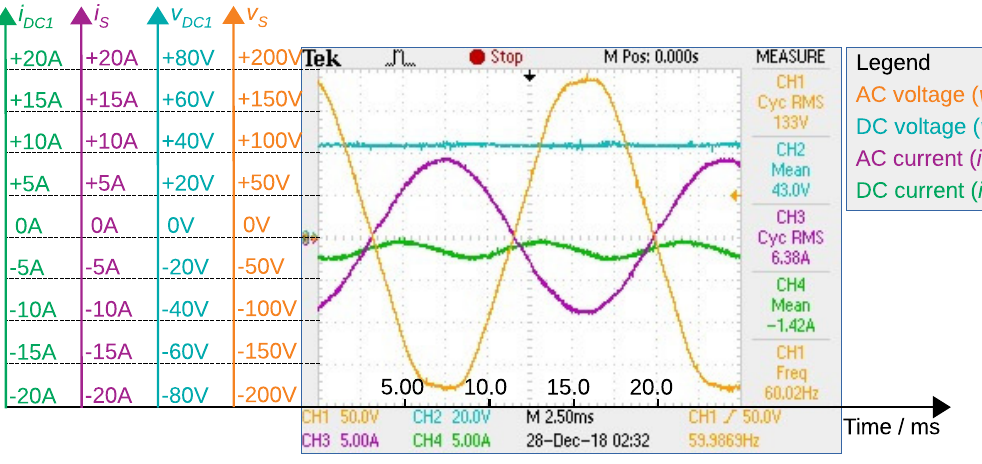
Figure 16. Measurements at 02:32 (of day 2)—Converter charging the batteries (stage II). Past t = 10 : 00 (of day 2) the batteries can be considered fully charged. The converter only needs to supply a minimum DC current to them in order to keep their DC voltage around the floating reference v DC ∗ = 40.5 V . It can be noticed in Figure 12 that the DC voltage is kept around its floating reference and the DC current, DC power, and AC power are kept near zero. Figure 17 presents the waveforms at stage III charge, taken at t = 13 : 31. Comparing Figure 17 with Figure 16, it can be seen that the AC current has well decreased its amplitude and RMS value to almost zero, the DC current has also well decreased its negative average value and the DC voltage has increased its average